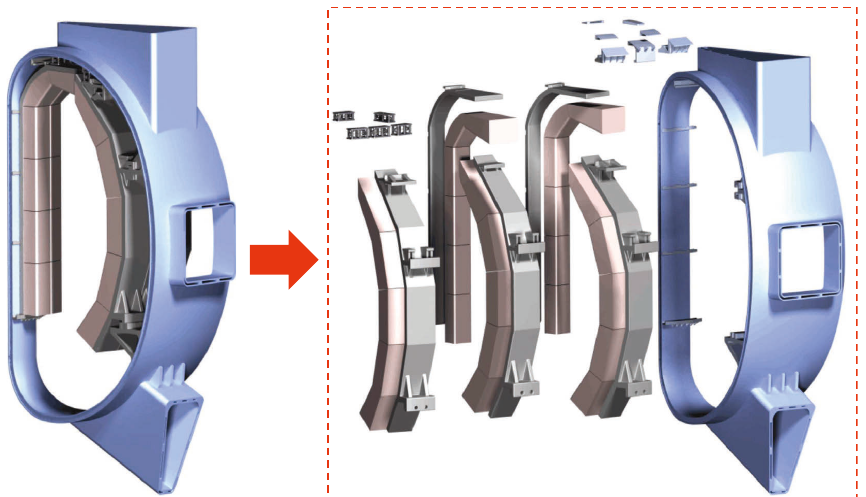
Figure 1: An exploded view of the CFETR blanket